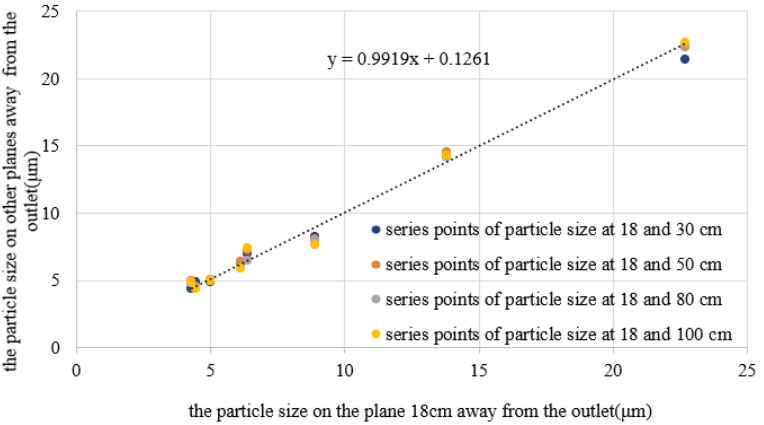
Figure 12. Particle size relationship between different target surfaces.